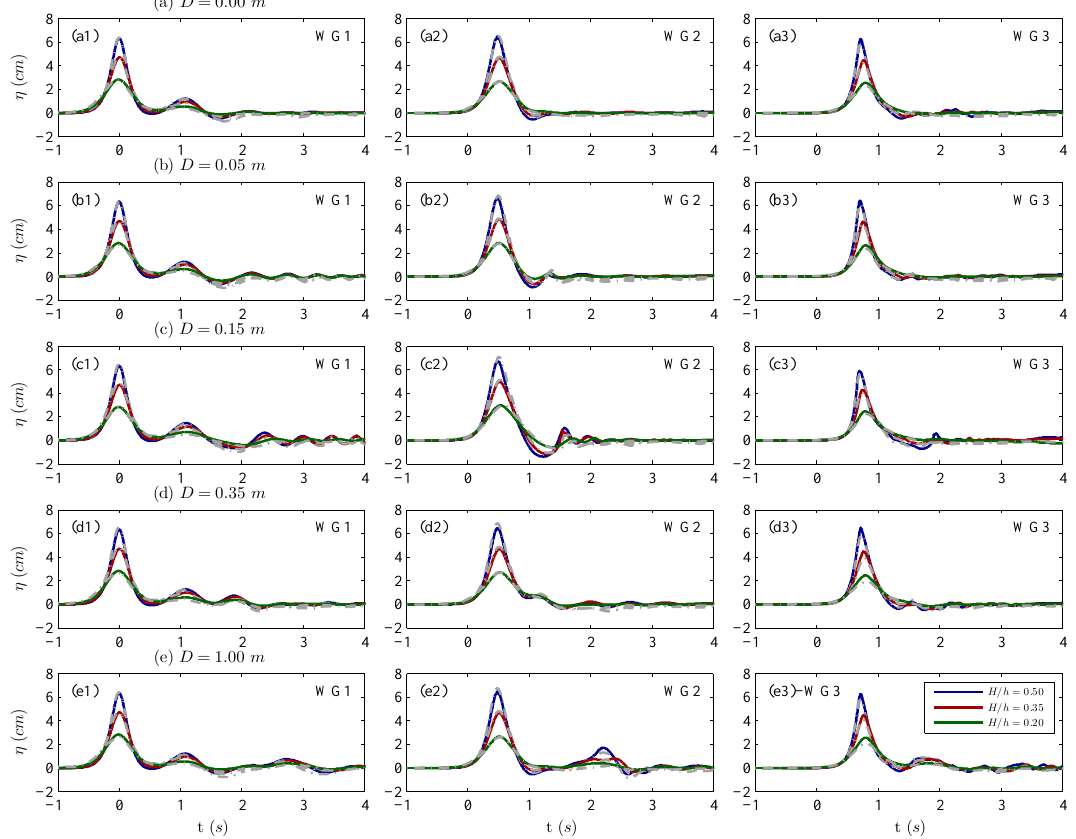
Figure 3. Model–data comparison in terms of free surface time series recorded by WG1, WG2 and WG3, for the cases of: ( a ) D = 0.00 m; ( b ) D = 0.05 m; ( c ) D = 0.15 m; ( d ) D = 0.35 m; and ( e ) D = 1.00 m. The solid lines and dashed lines correspond to the numerical and measured results, respectively.